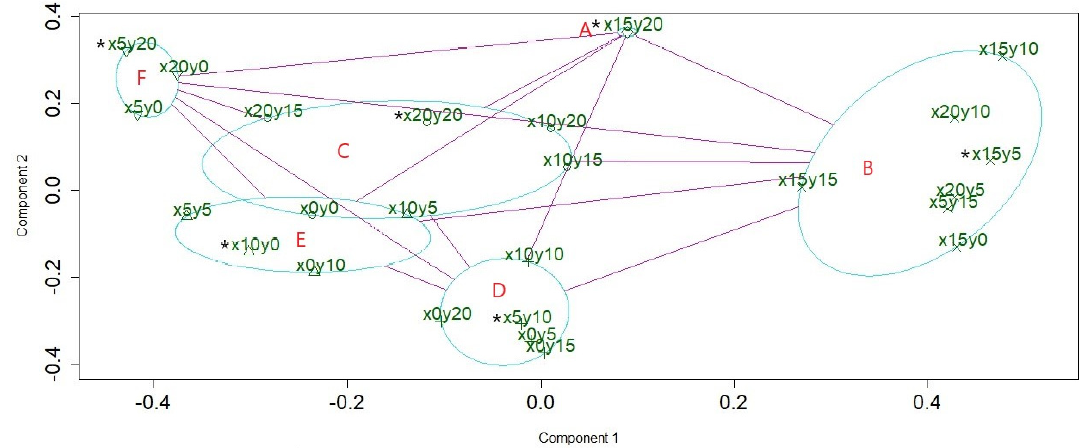
Figure 3. The clustplot shows the relationship of six community patterns with their members. The first two principal components explained 43.21% of the point variability. The medoid of a cluster is indicated with a